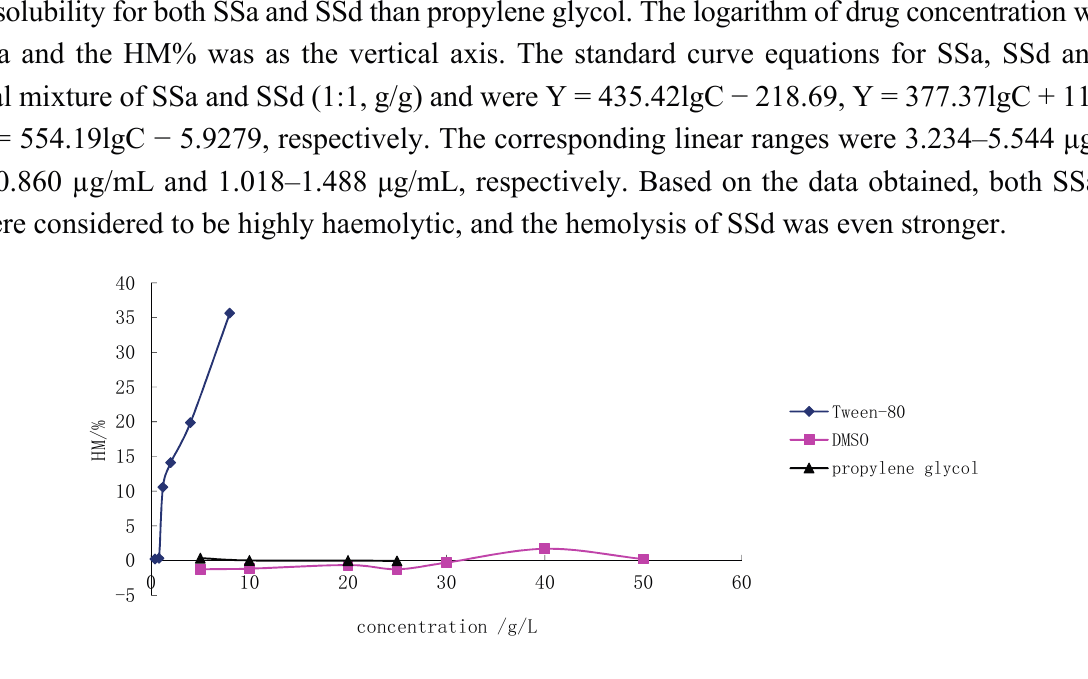
Figure 2. Hemolysis of different